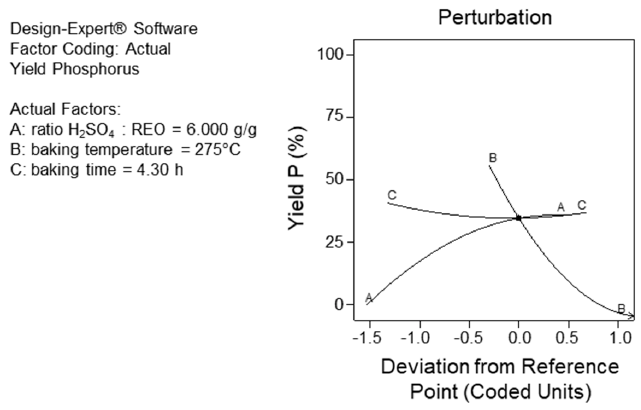
Figure 12. Perturbation plot for the response “Yield P.”